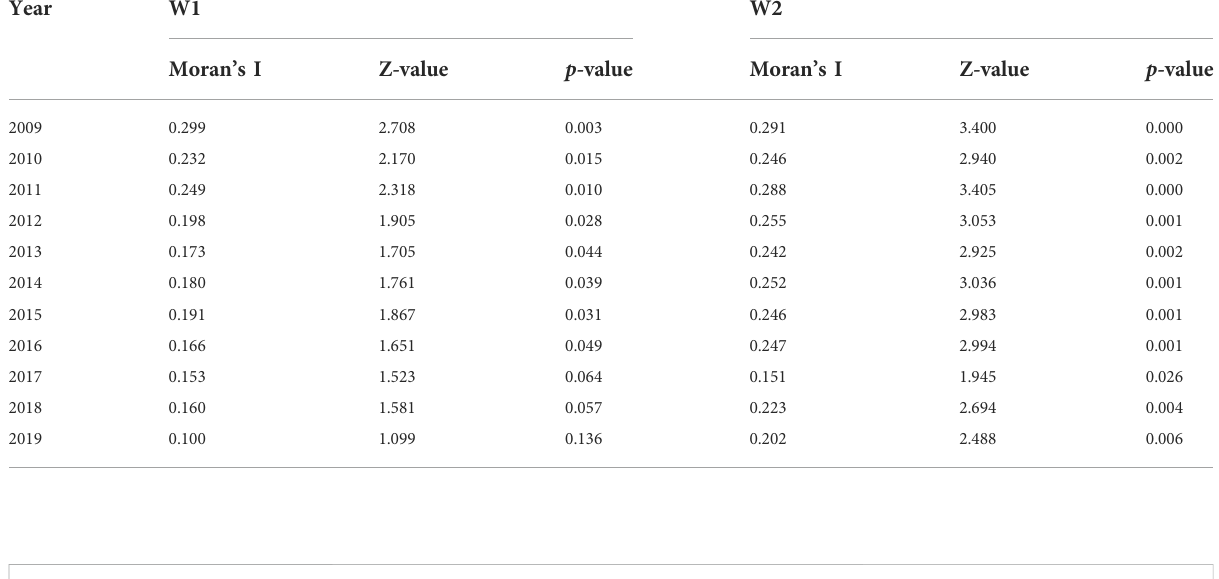
TABLE 5 Global Moran ’ s I for green credit 2009 to 2019.